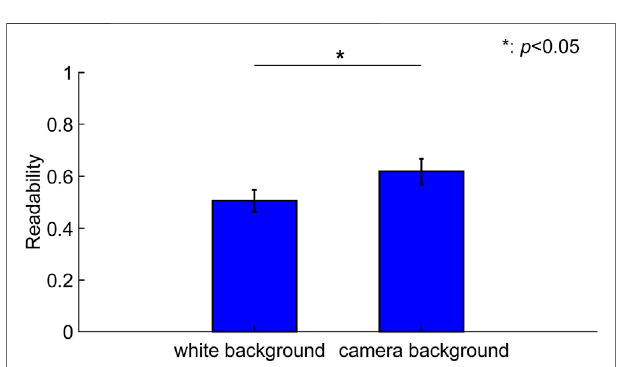
FIGURE 9 | Average readability of the book for each condition immediately after the task was completed. Books were signi fi cantly easier to read in the camera background condition than in the white background condition Error bars indicate the standard error. Asterisk indicates statistically signi fi cant difference (* p < 0.05).